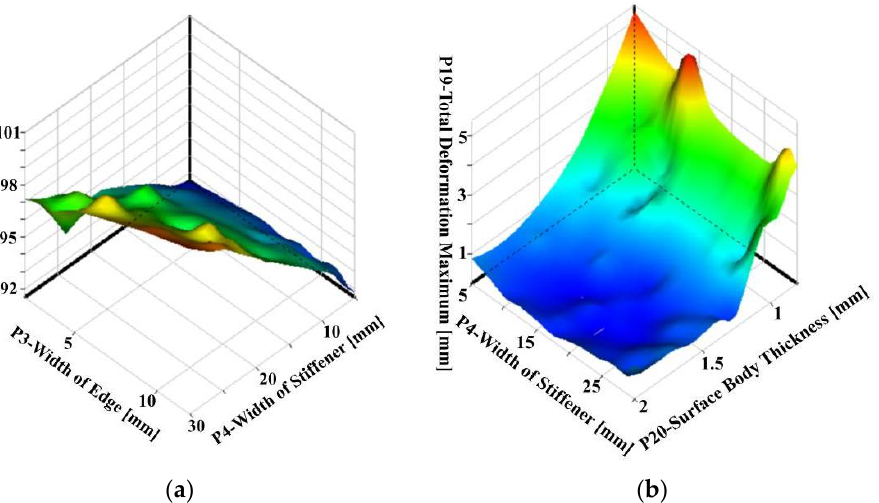
Figure 17. Kriging model. ( a ) Proxy model of fundamental frequency. ( b ) Proxy model of ampli- tude.